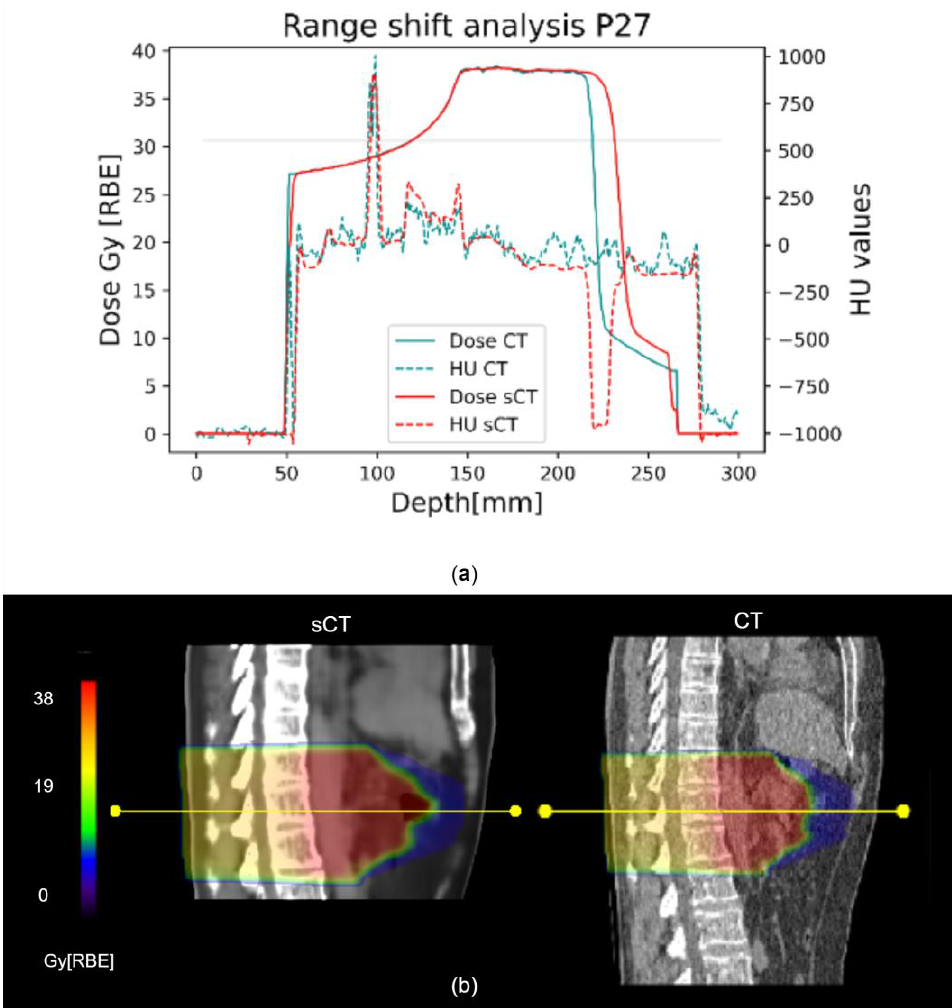
Figure 5. Representative range shift analysis on patient P27. ( a ) The graph shows both dose and HU profiles in CT (light blue) and sCT (red), evaluated along the yellow line shown in ( b ). The 80% reference is marked by the horizontal line. ( b ) Corresponding CT and sCT sagittal views are compared. The yellow line is one of the 10 considered for each beam, on different transversal slices.